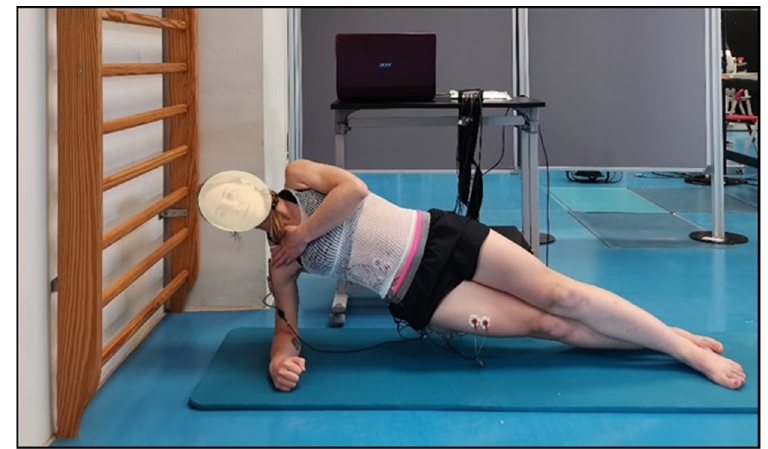
Figure 1. Participant performing the side bridge test on her right